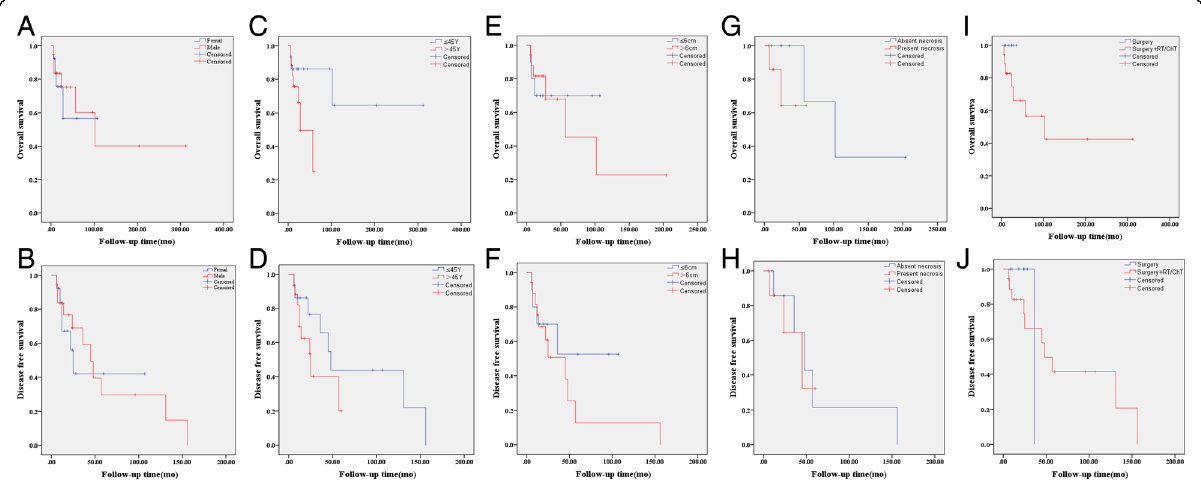
Fig. 6 Survival curves of mediastinal FDCS. OS and DFS curves of FDCS with various gender (Male or Female, a , b ), age ( ≤ 45y or > 45y, c , d ), tumor sizes ( ≤ 6 cm or > 6 cm, e , f ), necrosis situation (absent or present necrosis, g , h ). OS and DFS curves of FDCS with different treatments (surgery alone or surgery followed by RT and/or ChT, i , j ). OS, overall survival; DFS, disease-free survival. RT, radiotherapy; ChT,